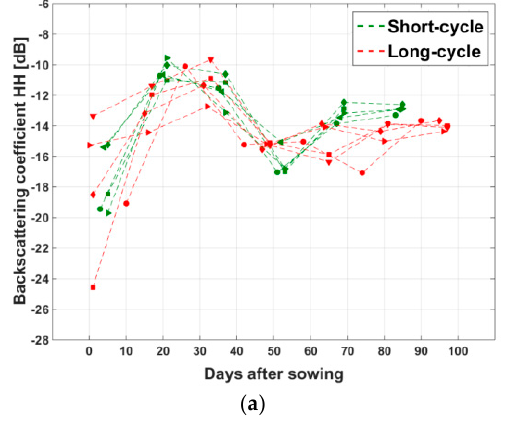
Figure 7. Variation of ( a ) HH, ( b ) VV backscattering coefficient, and ( c ) HH/VV of the five selected short-cycle sampled fields extracted from CSK images of six dates, versus the sowing date of each